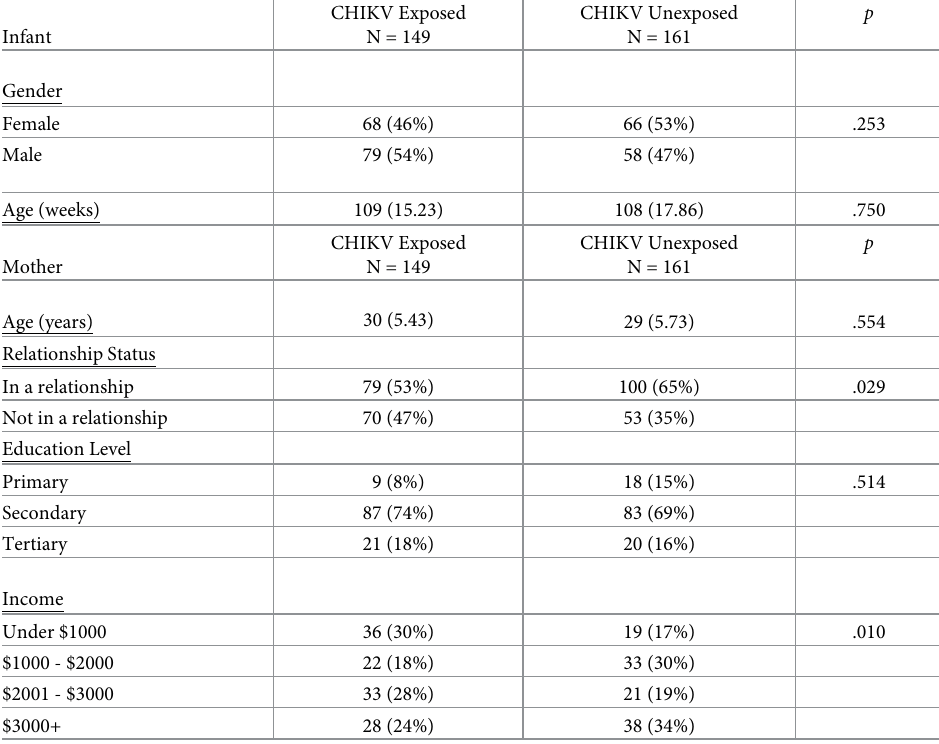
Table 2. Sample characteristics for CHIKV Exposed-Uninfected vs. Unexposed Children: Means and SDs.